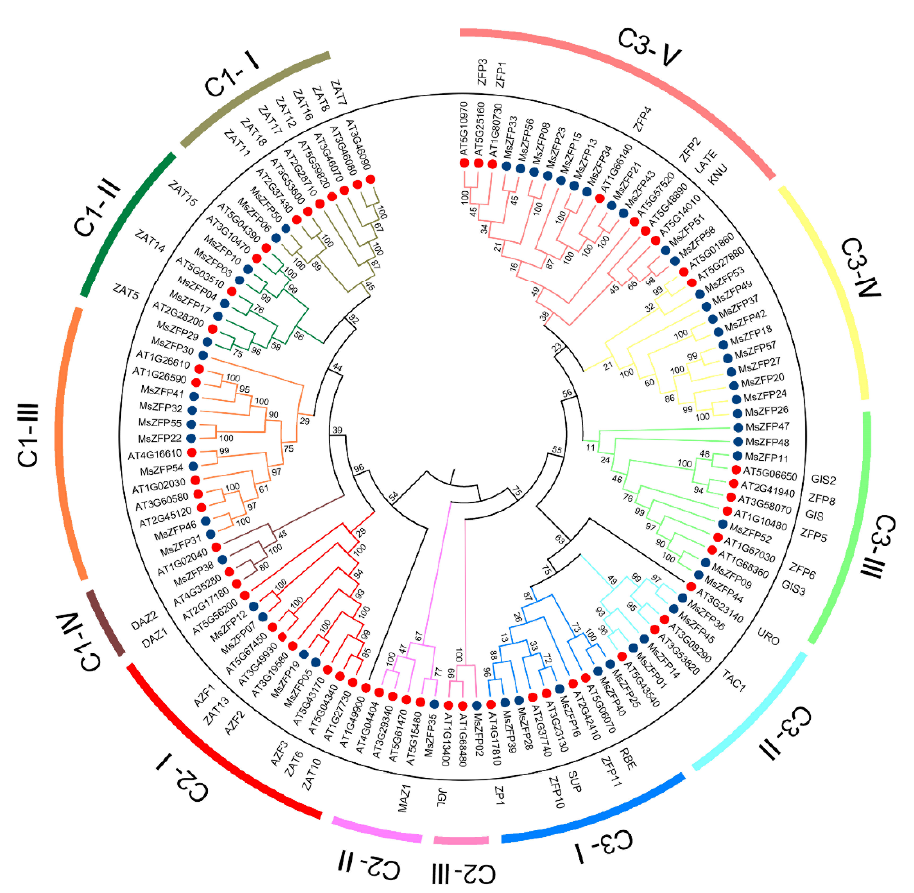
Figure 1. Phylogenetic analysis of Q-type MsZFP s; the phylogenetic tree was created using the MEGA 6.0 program (bootstrap value set at 1000 with neighbour-joining). The phylogenetic tree represents the relationship between 58 Q-type C2H2-ZFP genes of alfalfa and 58 Q-type C2H2-ZFP genes of Arabidopsis . All C2H2-ZFP genes were clustered into five clades and twelve groups, distinguished here by different colours.